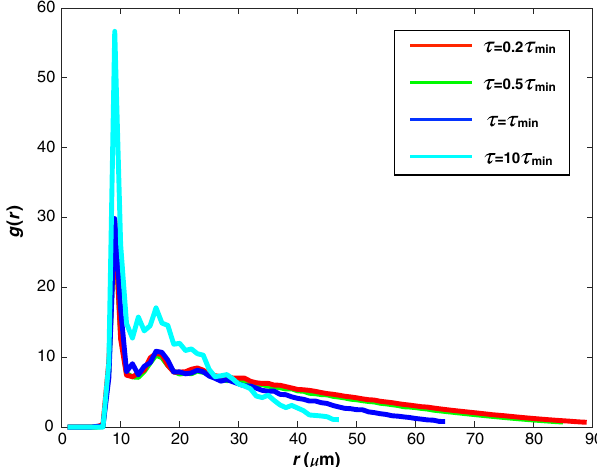
FIG. 7. Pair correlation function at four different cell division , for times ( τ ): 0 . 2 τ (red), 0 . 5 τ (green), τ (blue), and 10 τ min min min min min . (cyan). The cells are packed more closely at longer cell cycle min times as reflected by the sharper peak for the cyan line compared to the others. The distance r at which g ð r Þ approaches zero is considerably smaller for τ ¼ 10 τ . The distance at which the min ≈ 10 μ m (Table I), which first peak appears is approximately 2 R m implies that, despite being soft, the cells in the interior are densely packed, as in a body centered cubic